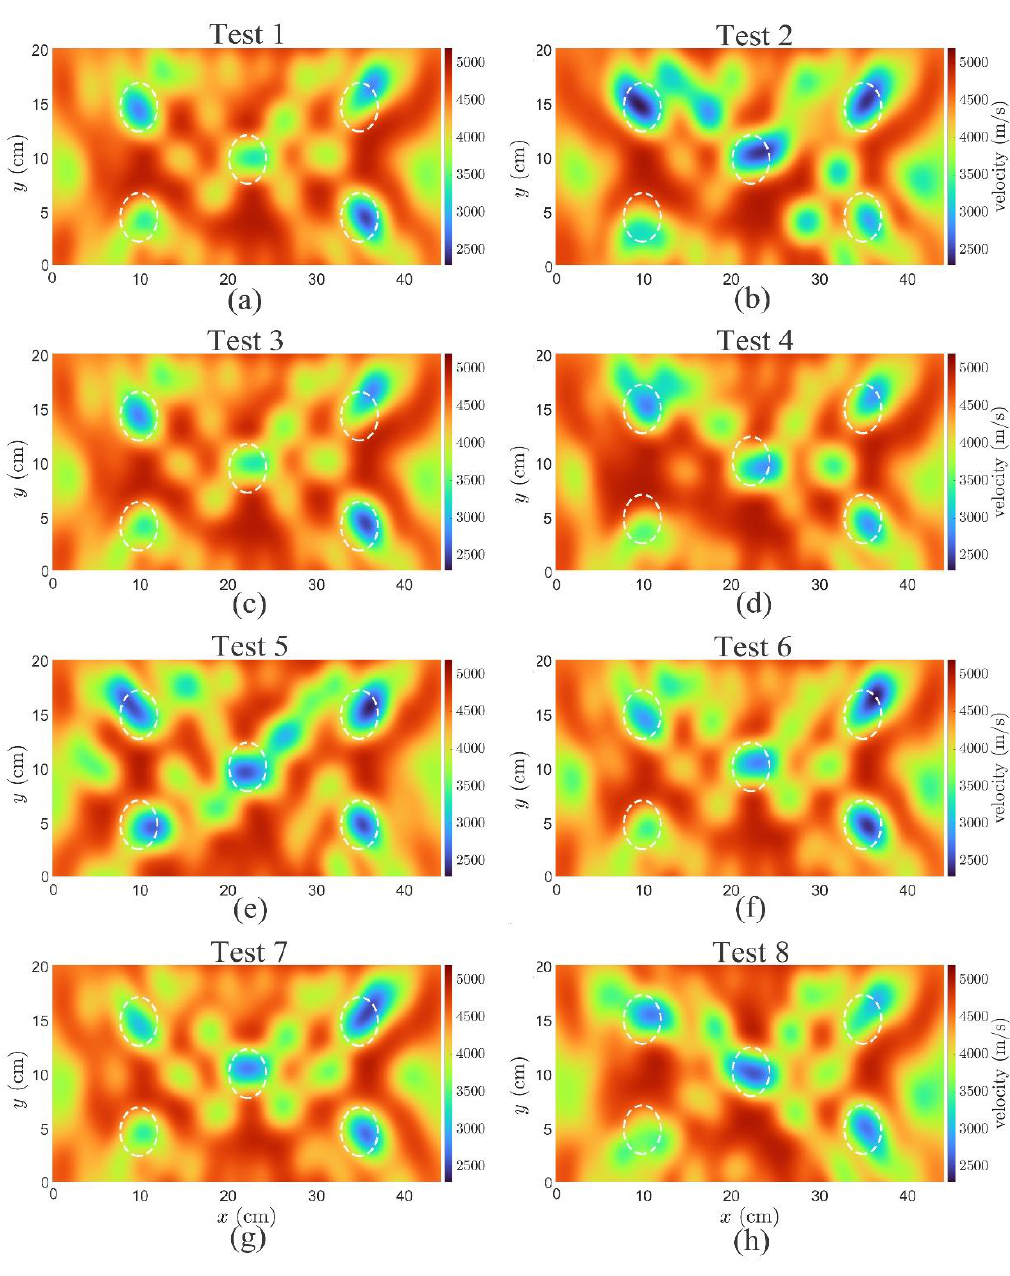
Figure 13. Tomographic results for TDAT in robustness tests with different systematic errors and random noises. The white dotted lines delineate the original anomalous areas.